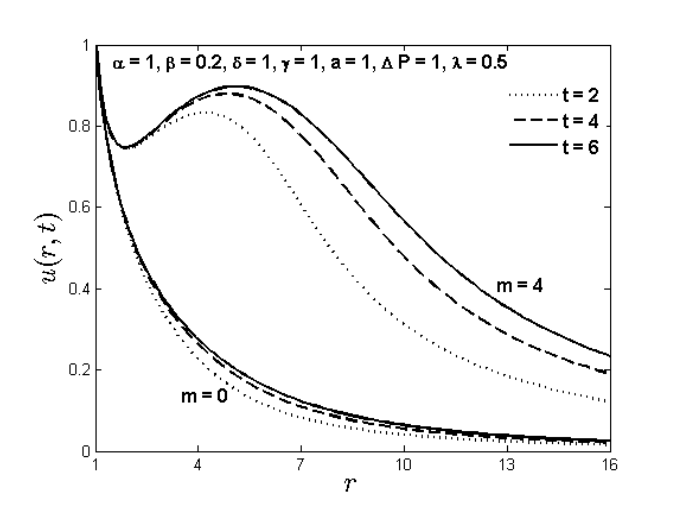
Figure 3. Solid displacement as a function of radial distance for various values of time t and permeability parameter m .